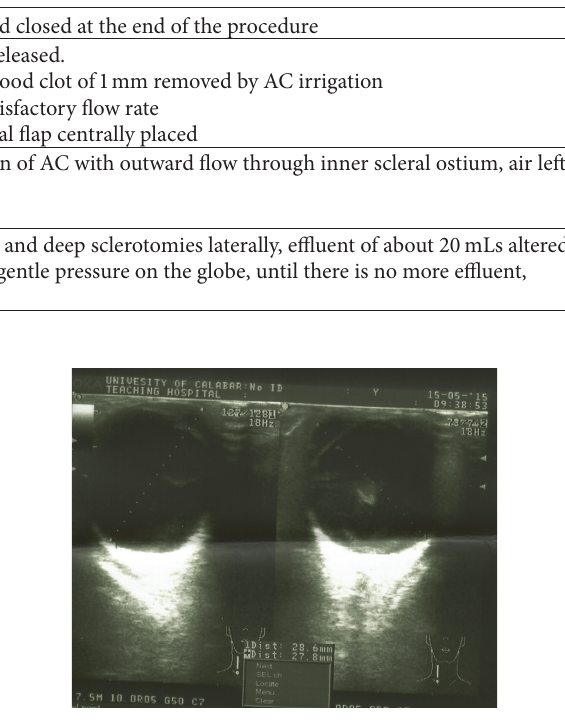
Figure 3: Left ocular B scan six weeks after suprachoroidal hemor- rhage